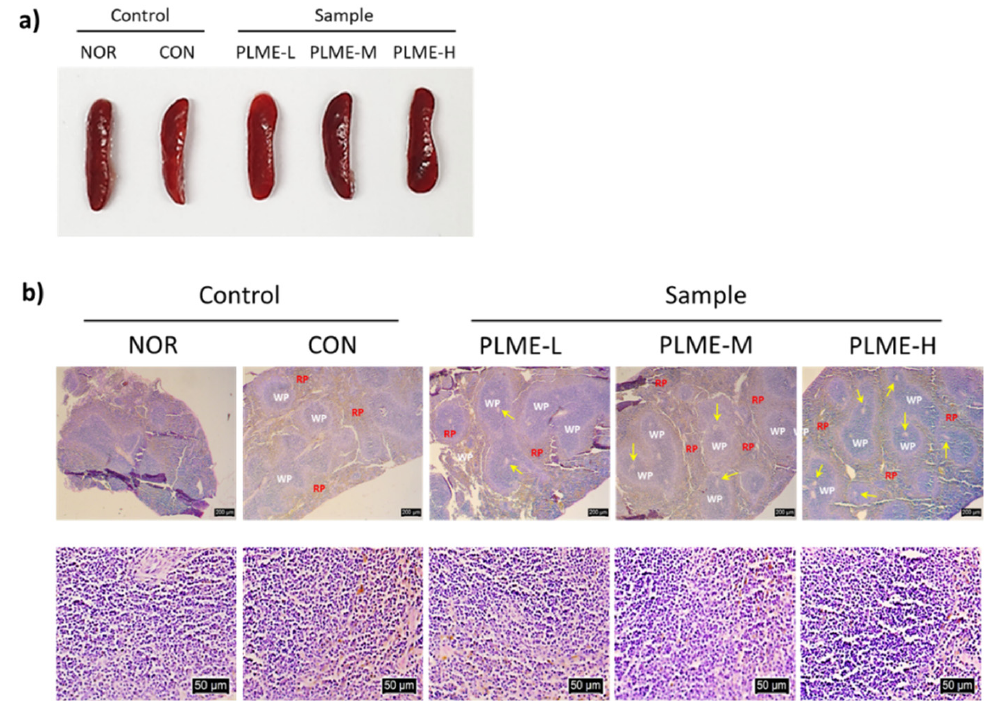
Figure 2. Effect of PLME administration on the spleen tissue: ( a ) Representative images of spleen tissue; ( b ) representative microscopic images (magnification ×200) of spleen biopsy stained with H & E. Scale bar = 200 μ m (upper) or 50 μ m (bottom). WP, white pulp; RP, red pulp; yellow arrows indicate central arteries at white pulp area of spleen tissue. NOR, normal group administered tap water; CON, medium control group administered only culture medium (250 mg/kg/day); PLME-L, PLME-M, and PLME-H, sample groups administered postbiotics prepared from P. linteus mycelial submerged culture at doses of 250, 500, and 1000 mg/kg bw/day, respectively.